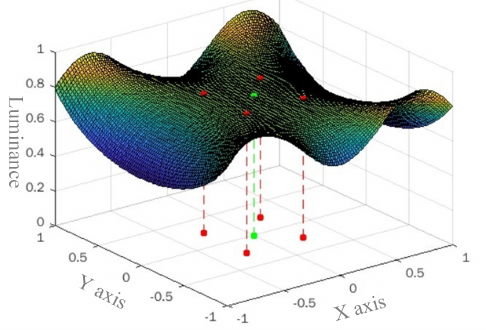
Figure 1. The local distribution of an LR pixel in situation. The green point denotes the pixel in the LR image, and the red point denotes the corresponding sub-pixels in the HR